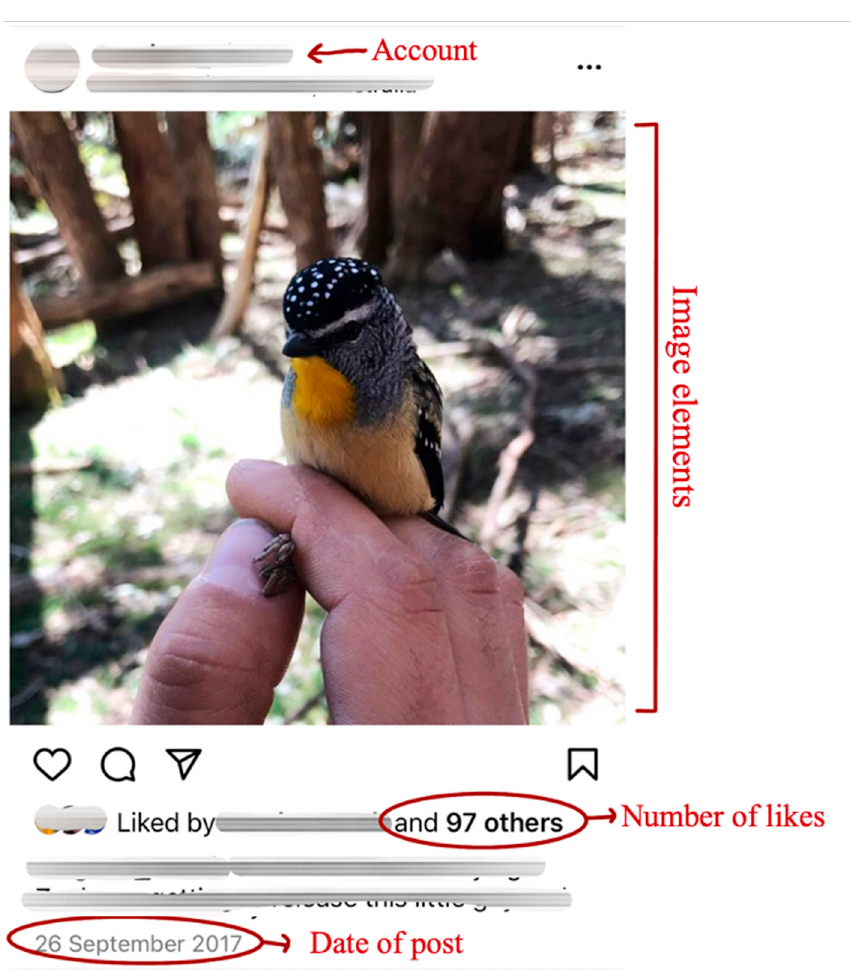
Figure 1. Example Instagram post and the types of data collected (in red) M. Shaw (2015).